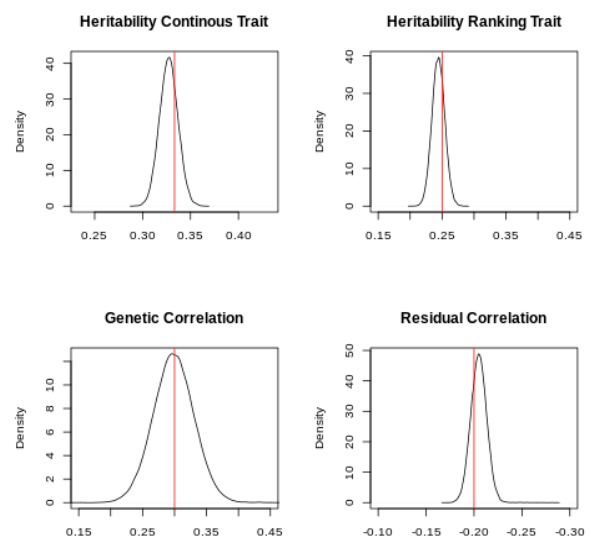
Figure 2. Posterior distribution and simulated parameters (in red) of the heritabilities of the continuous and ranking traits and of the genetic and residual correlations.